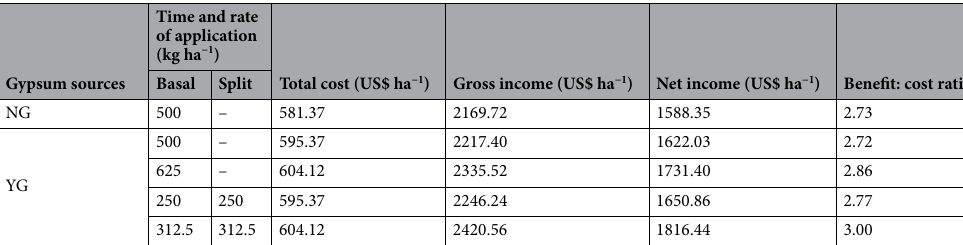
Table 6. Economic analysis of groundnut growing under different YG rates and application timings based on current prices (Pooled data). Current price (US$): Groundnut kernel—$0.81/kg, Groundnut haulm—$0.013/ kg, Yellow gypsum—$0.067/kg, Natural gypsum—$0.040/kg. NG natural gypsum, YG yellow